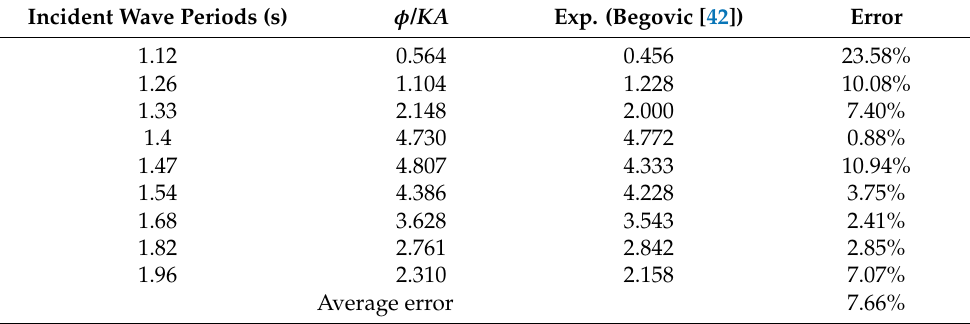
Table 3. The wave conditions used in the computation.